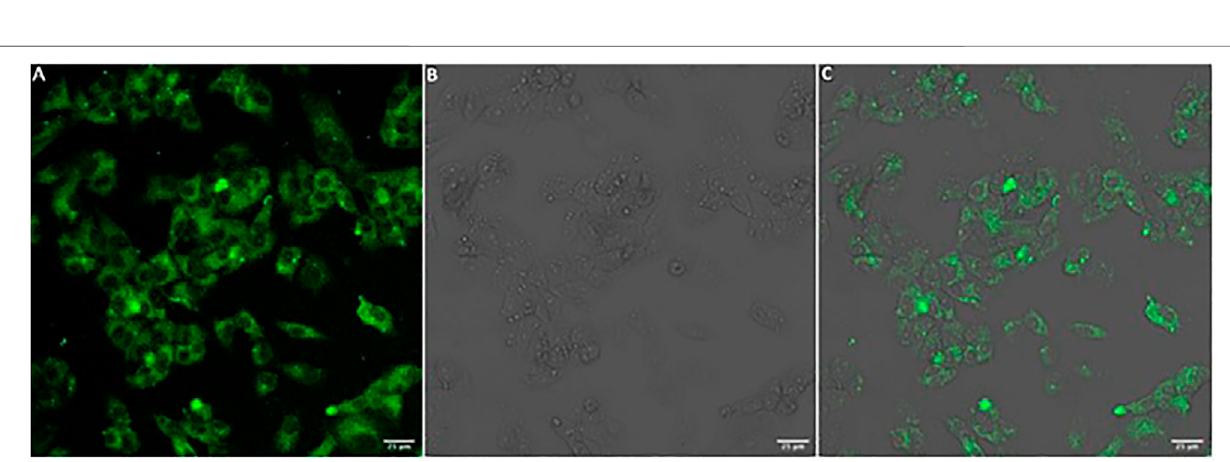
Frontiers in Chemistry |